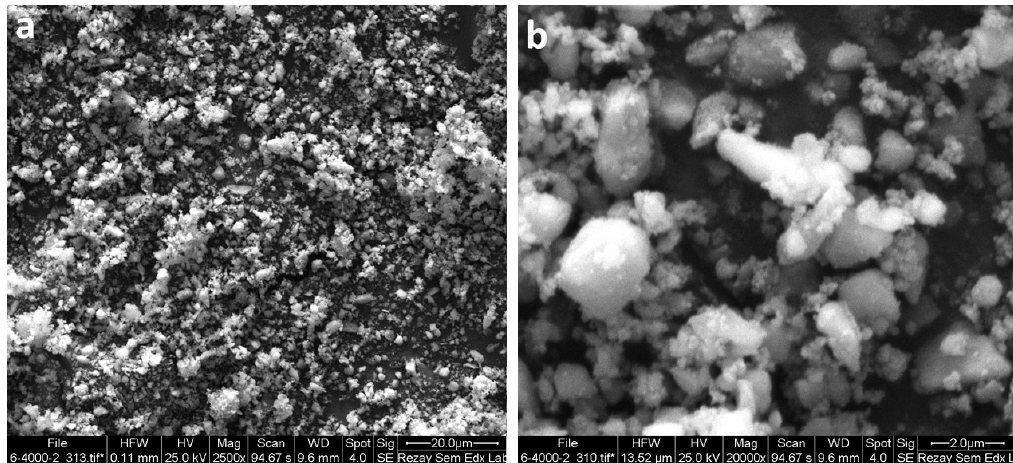
Figure 5. Scanning electron microscopy (SEM) images of the synthesized NimMOF at two different magnifications ( a ) and ( b ).